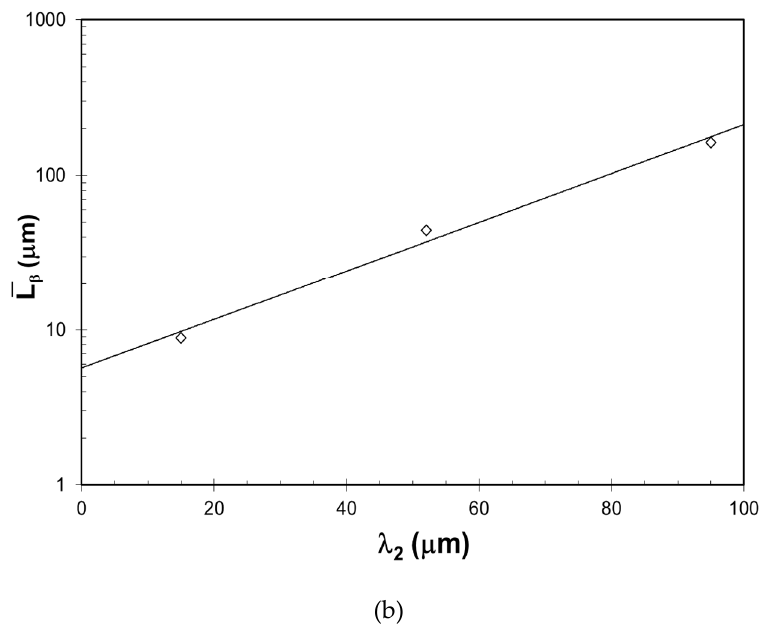
Figure 5. The correlation between λ 2 , and ( a ) maximum pore length (data from [75]), and ( b ) length of β –Al 5 FeSi platelets (data from [76,77]).